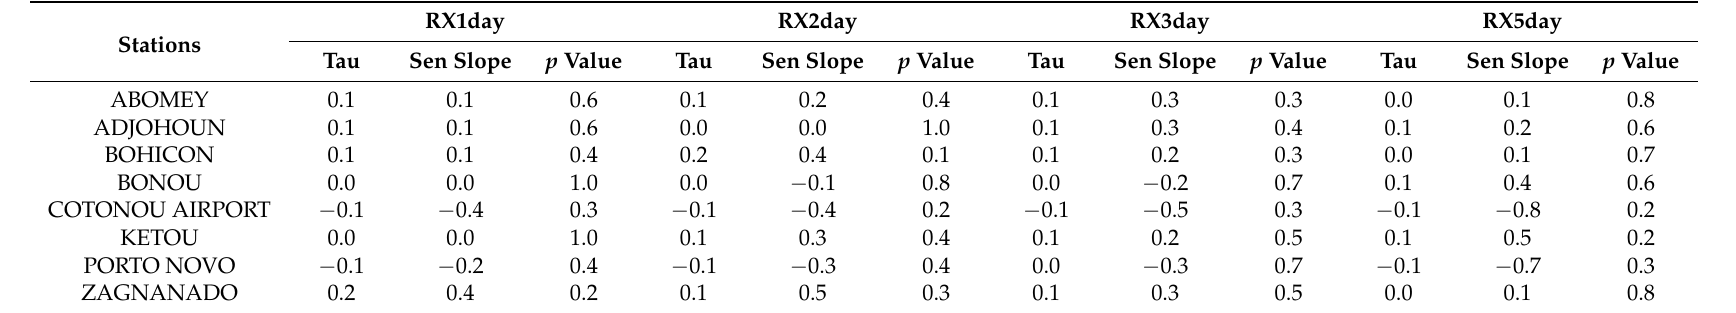
Table 5. Annual rainfall intensity indices with no trend.